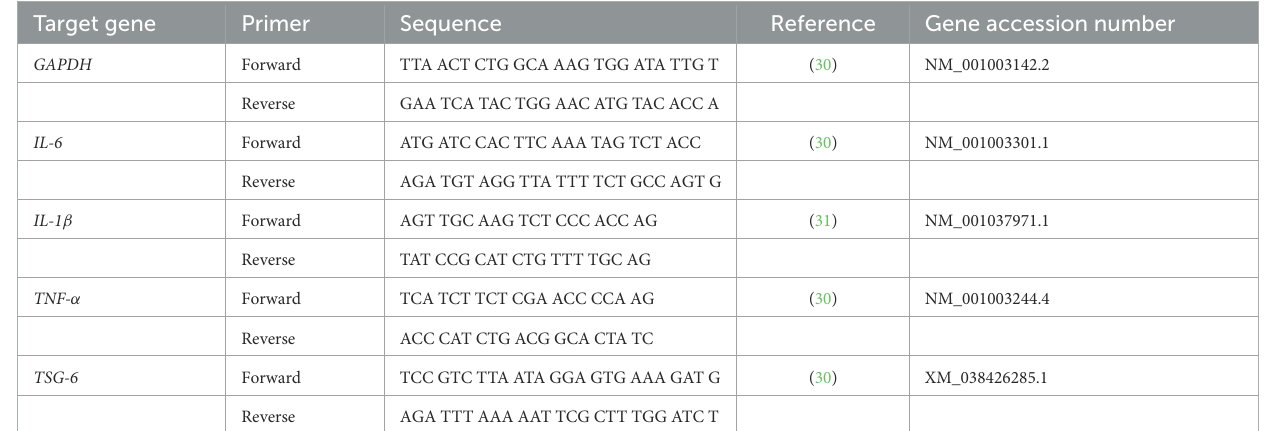
TABLE 1 Primer sequences for canine genes assessed in this